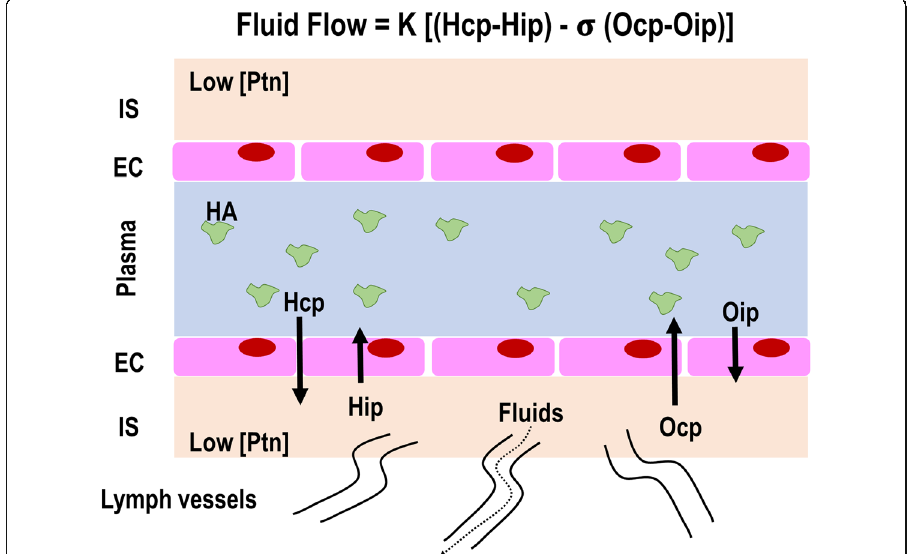
Fig. 1 Fluid filtration according to the classic Starling model. Fluid filtration is mainly guided by the difference between the hydrostatic gradient [hydrostatic capillary pressure (Hcp) and hydrostatic interstitial pressure (Hip) multiplied by K (permeability index)] and oncotic gradient [oncotic capillary pressure (Ocp) and oncotic interstitial pressure (Oip) multiplied by δ (reflection coefficient)]. The interstitial space (IS) is considered to have a low protein concentration [Ptn]. Residual fluids situated in the IS would return to